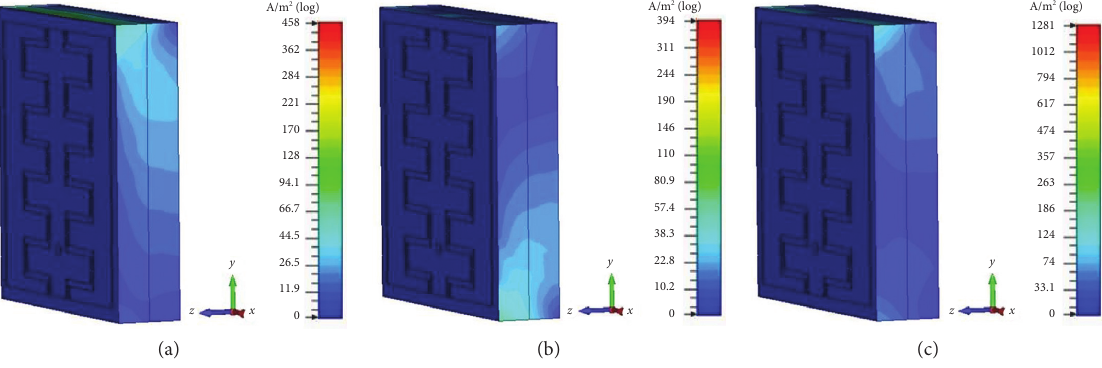
Figure 9: The current density simulation results of ICPW-EBG unit cell at (a) 1.8 GHz, (b) 2.45 GHz, and (c) 3.7GHz.